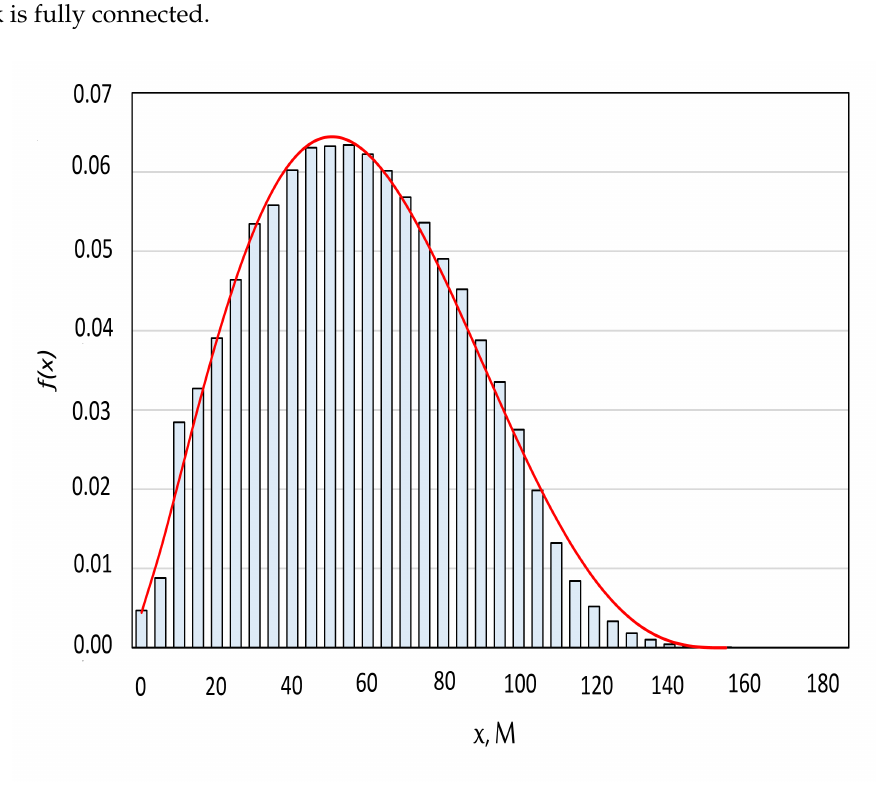
Figure 11. Distribution of the length of the shortest